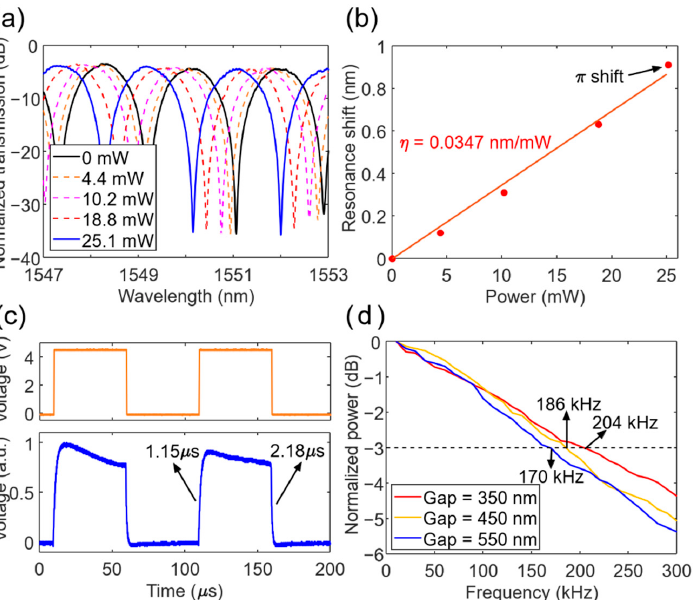
Figure 5. ( a ) Transmission spectra of the MZI for different heating powers (Gap = 450 nm). ( b ) Res- onance shifts for the interference dips at 1551.06 nm for different heating powers (Gap = 450